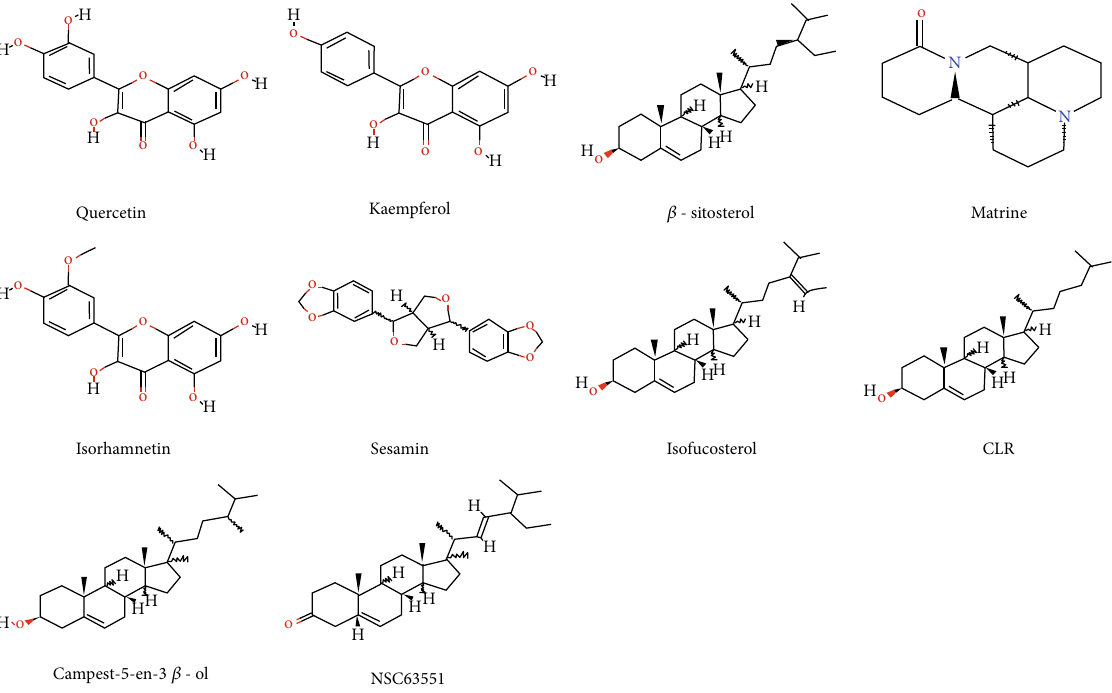
Figure 3: The structure of 10 bioactive compounds of